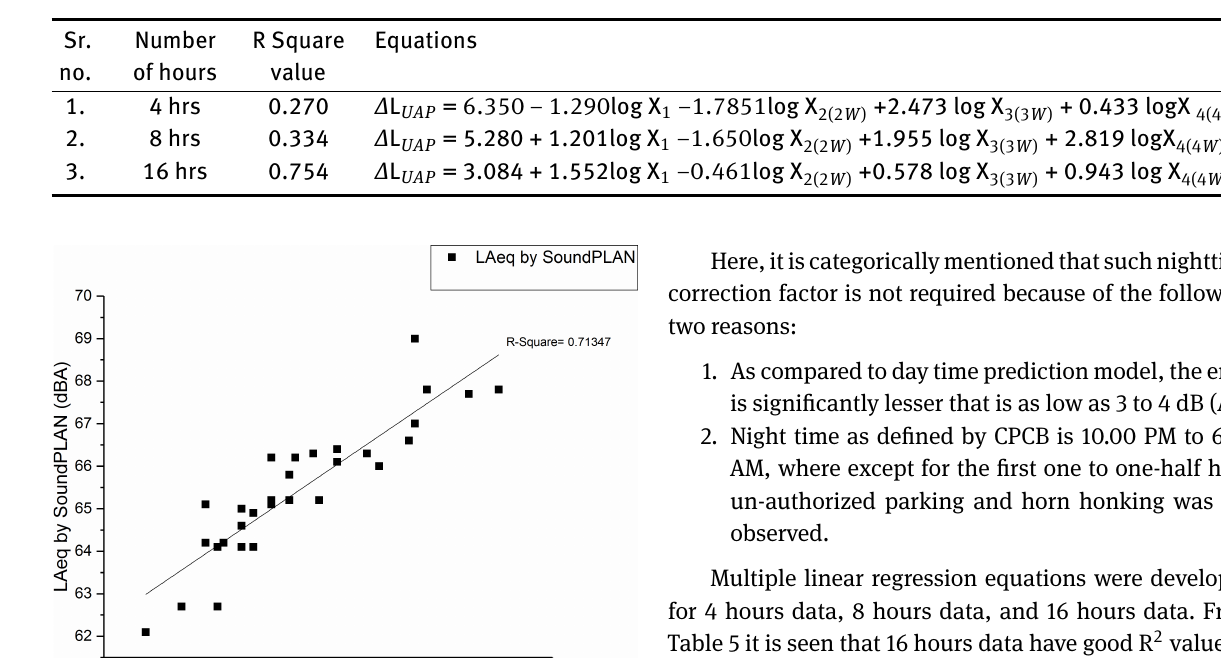
Table 5: Horn honking based correction models